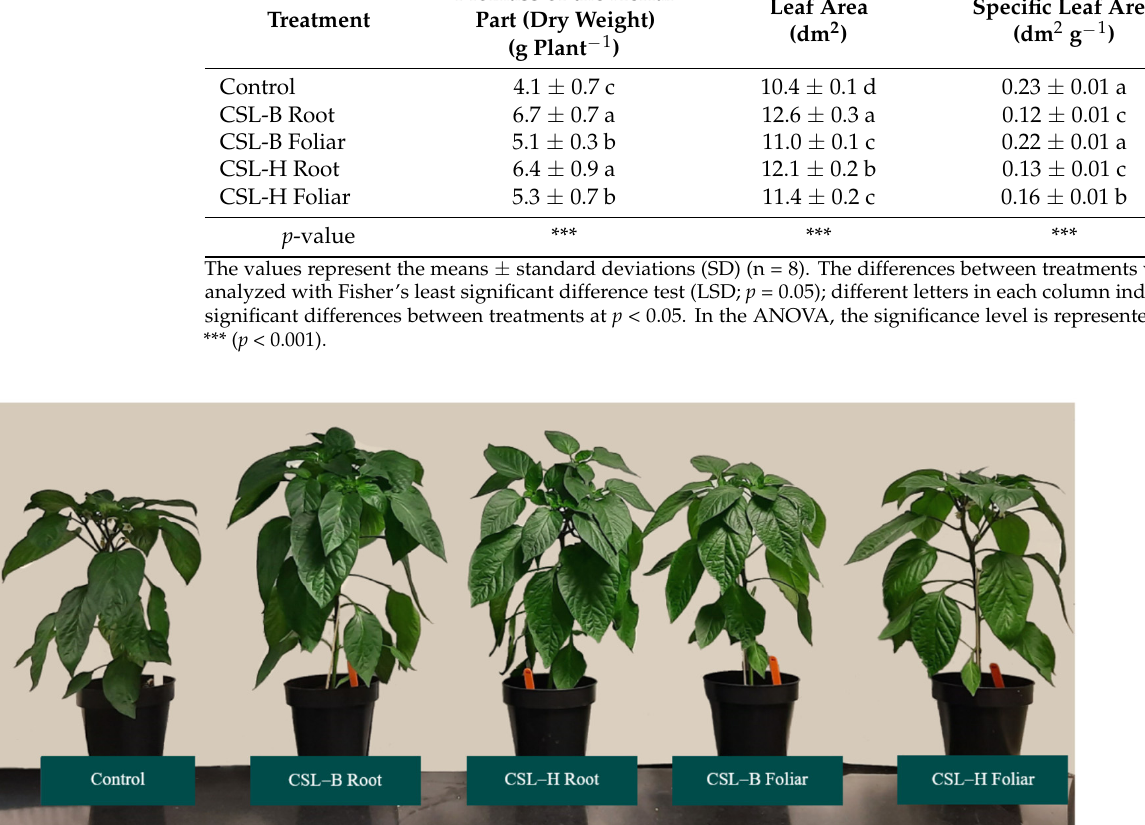
Table 1. Biomass of the aerial part, 7 days after the last application of the treatments to the plants. Biomass of the Aerial Part (Dry Weight) Treatment